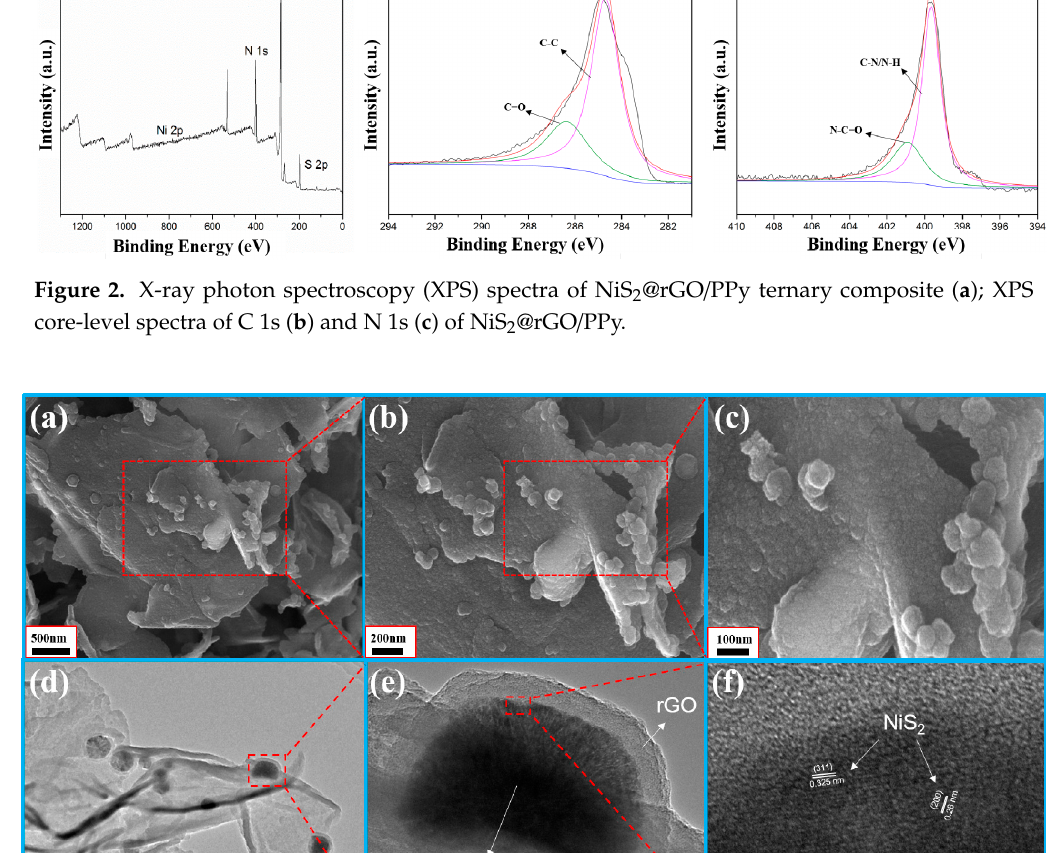
Figure 1. ( a ) X-ray diffraction (XRD) patterns of the NiS 2 @rGO/PPy ternary composite and the NiS 2 @rGO binary composite; ( b ) Fourier transform infrared (FT-IR) spectra of the PPy and NiS 2 @rGO/PPy ternary composites.